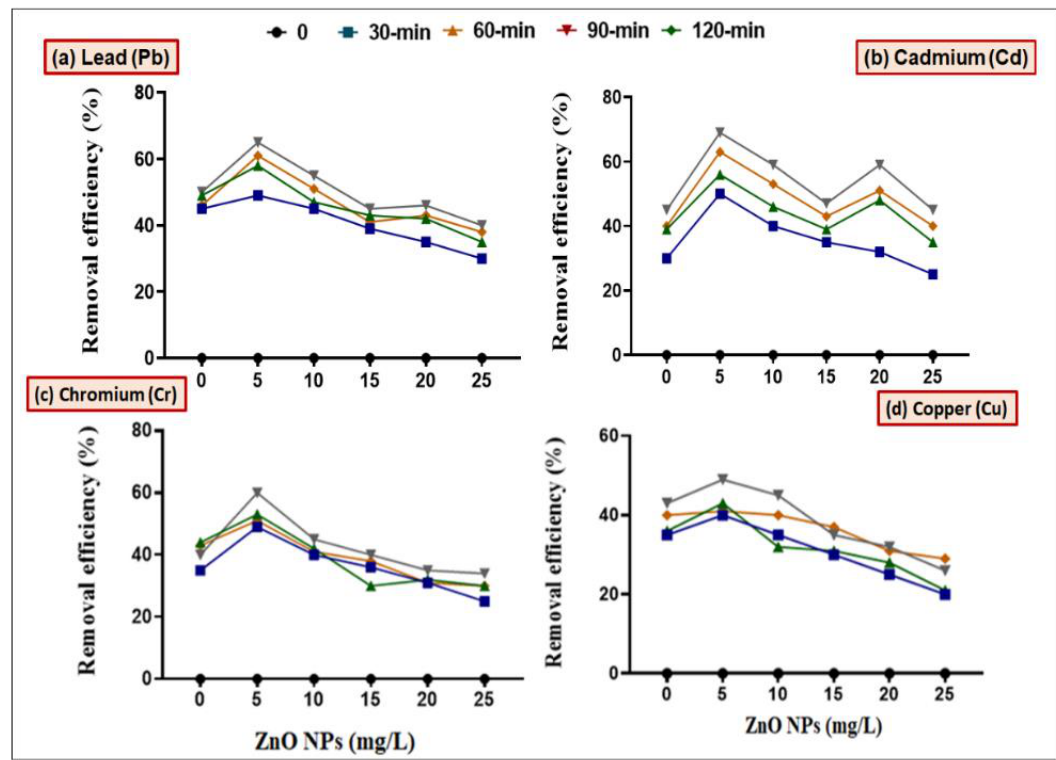
Figure 4. Synergistic effect of Lysinibacillus macrolides and ZnO NPs (5, 10, 15, 20 and 25 mg/L) on the removal efficiency of ( a ) Lead (Pb), ( b ) Cadmium (Cd), ( c ) Chromium (Cr) and ( d ) Copper from the media amended with heavy metal at different time intervals (0, 30, 60, 90 and 120 min).